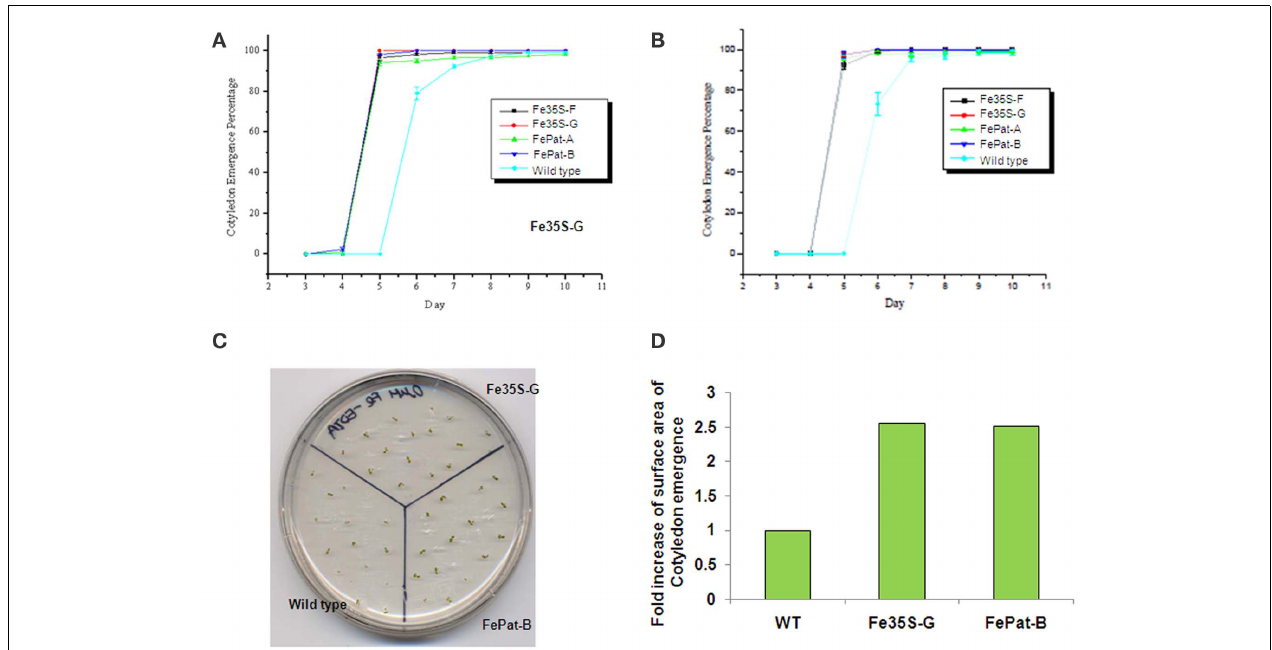
ImageJ based measurement of Arabidopsis cotyledon emergence grown under iron sufficient [50 μ M Fe(III)-EDTA] media at day 14. Surface area was measured for 20 plants for each transgenic and wild-type line.Values for wild-type were normalized to 1 and the fold increase for the transgenic plants is